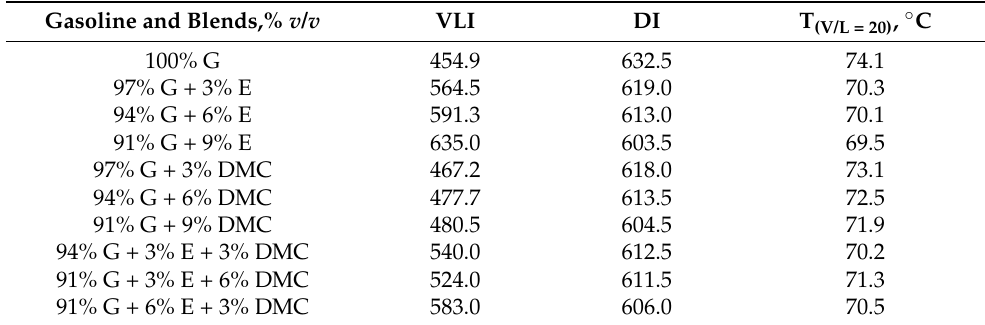
Table 4. The effect of adding ethanol and DMC to gasoline on the vapor lock index (VLI), drivability index (DI) and vapor–liquid